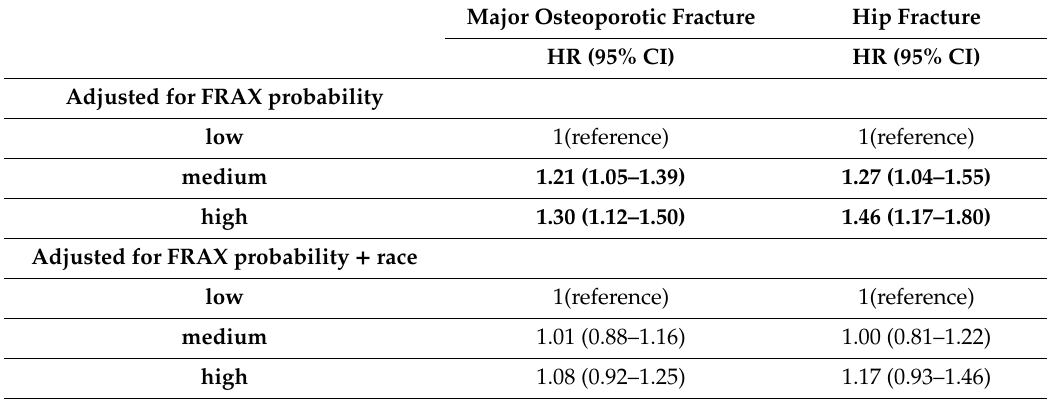
Table 2. Hazard ratios (HR) with 95% confidence interval (CI) for outcomes of incidence fracture according to the GRS group, adjusted for FRAX score: Results of multivariate Cox proportional hazard model.